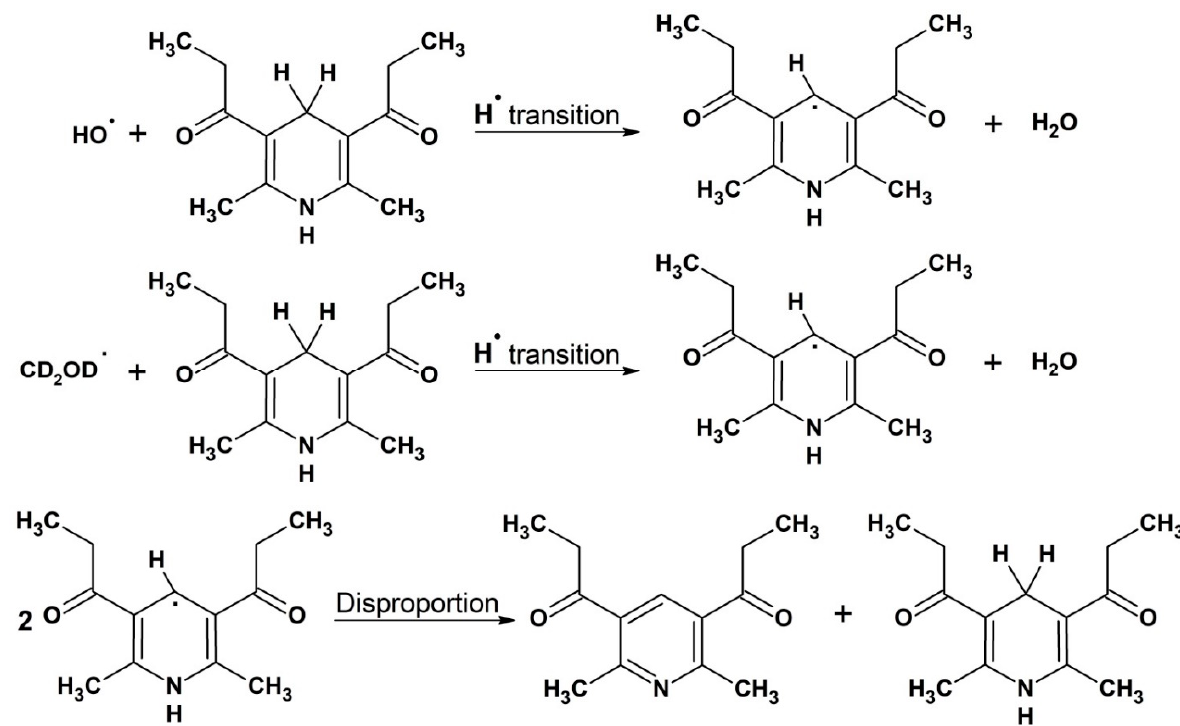
Figure 7. Scheme of the oxidation of 1,1 ′ -(2,6-dimethyl-1,4-dihydropyridine-3,5-diyl)di(propan-1-one) (DHP). DHP reacts with a hydroxyl radical or • CD 2 OD C-centered radical to form a DHP neutral radical. Subsequently two DHP radicals may be involved in the disproportionation reaction to form the initial DHP and 1,1 ′ -(2,6-dimethylpyridine-3,5-diyl)-di(propan-1-one).